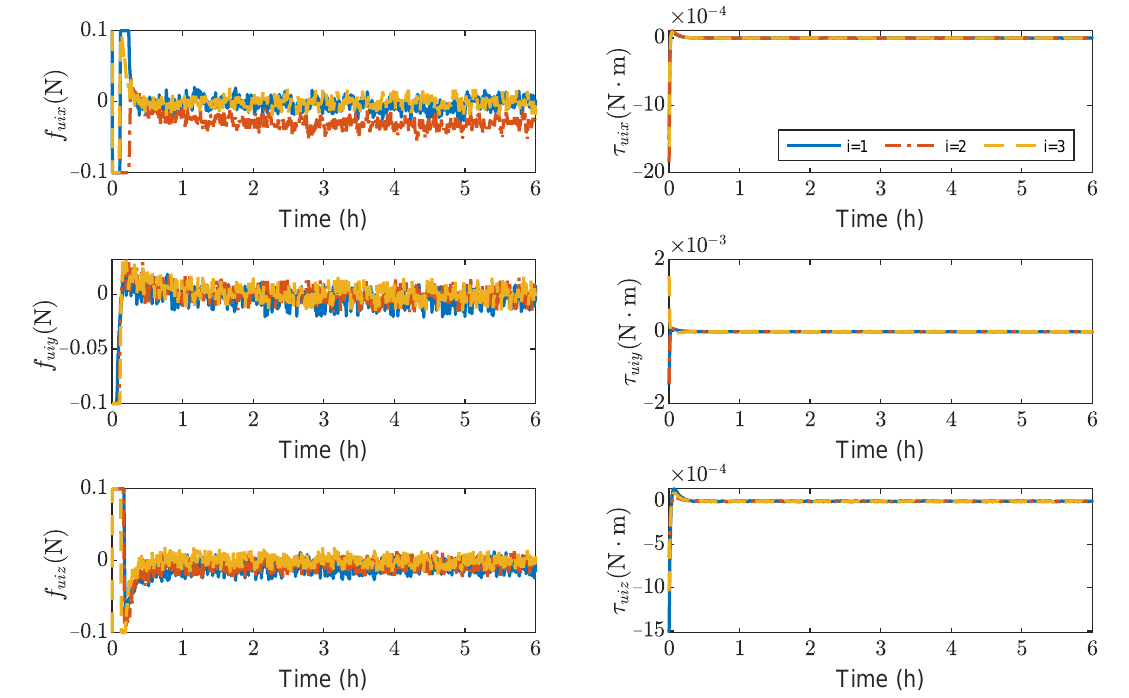
Figure 17. Control forces and control torques about SC1 ∼ 3, the max control force of spacecraft is 100